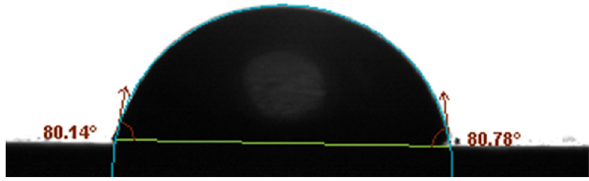
Figure 5: Contact angle of ROGU - coated